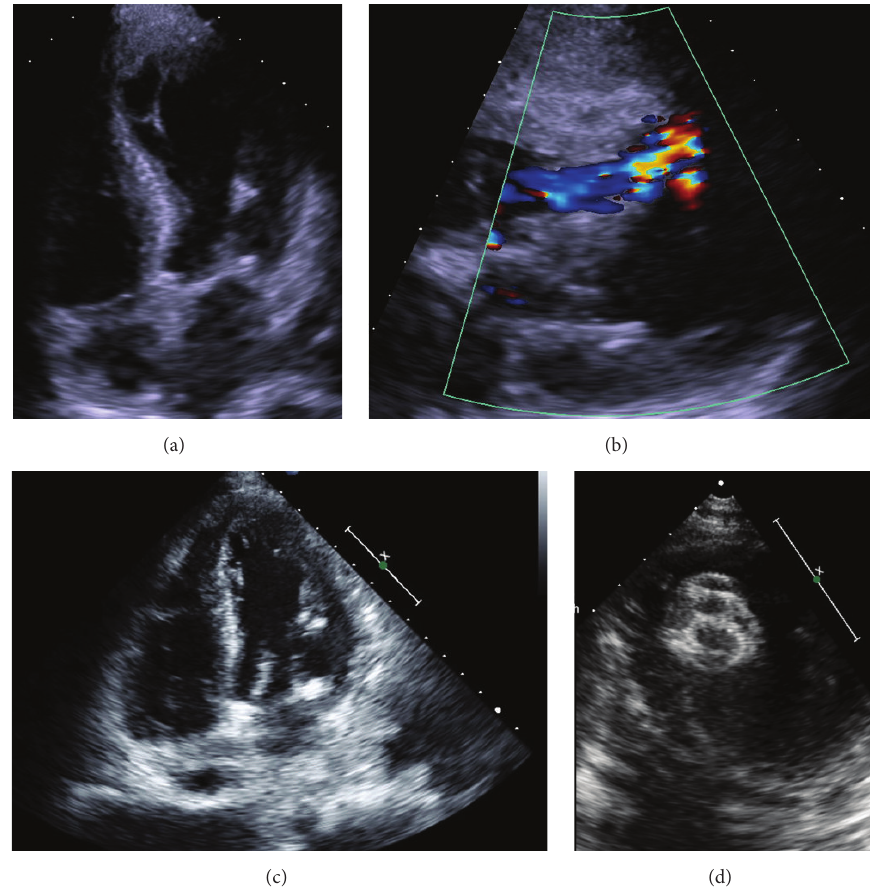
Figure 1: (a) Outside hospital TTE. Apical 4 chamber view demonstrating left ventricular apical ballooning. (b) Outside hospital TTE. Subcostal view demonstrating VSD with left to right shunt. (c) TTE 11 days later with recovery of left ventricular morphology. (d) Amplatzer in place after repair of